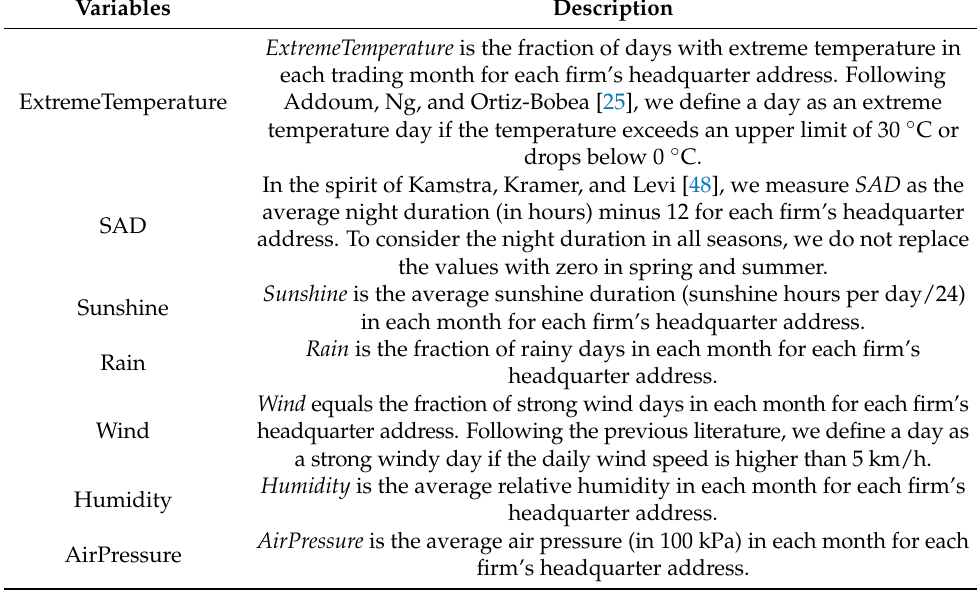
Table 1. Variable